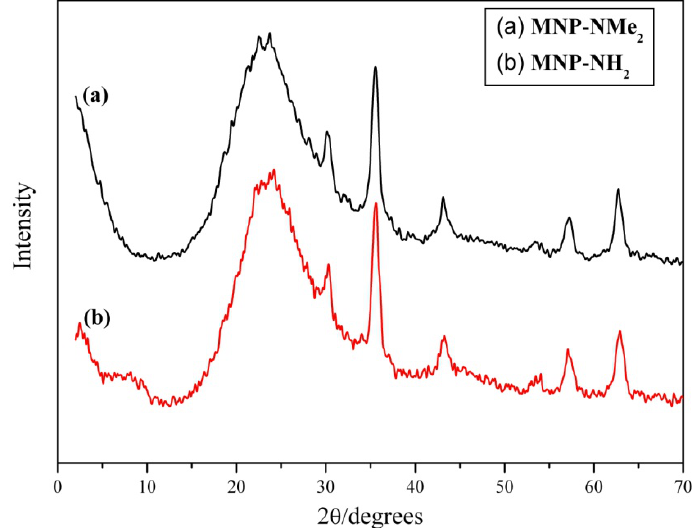
Figure 7. TGA-DTA curves of ( a ) SG-MNP-NH